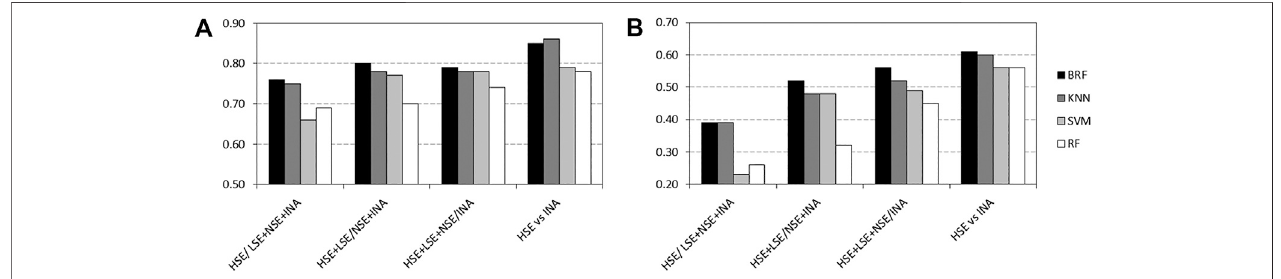
FIGURE 4 | Comparison of (A) Balanced Accuracies (BA) and (B) Matthews Correlation Coef fi cients (MCC) values for the top performing TPO classi fi ers. White barsrefertoRandomForests,lightgreybarsrefertoSupportVectorMachines,darkgreybarsreferstok-NearestNeighborwhileblackbarsreferstoBalancedRandom Forests.